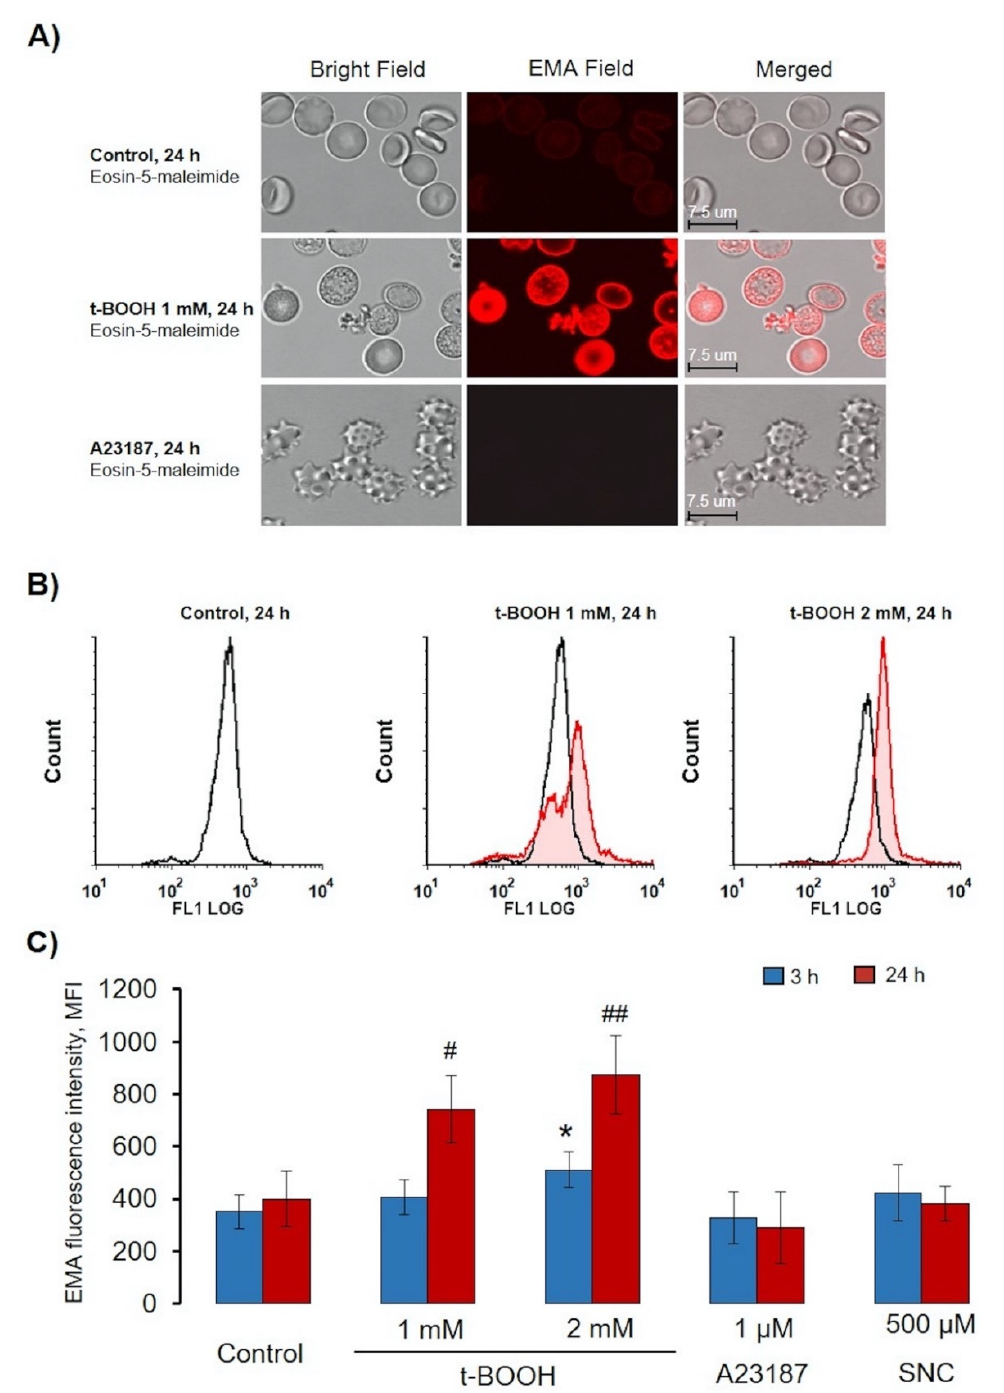
Figure 10. t-BOOH-induced oxidative stress led to band 3 clustering and MV formation. RBCs (0.5 × 10 9 cells / mL) were incubated as indicated with t-BOOH, A23187, and SNC at the indicated times, followed by EMA staining (0.07 mM, 40 min). ( A ) Representative confocal images of t-BOOH transformed RBCs. RBCs were processed for confocal microscopic analysis as described in the Materials and Methods section (Section 2.2.7). ( B ) Original histograms of EMA fluorescence intensity after 24 h t-BOOH treatment. ( C ) Quantification of flow cytometry data. Data are presented as mean ± SD ( n = 7), one-way ANOVA, Levene’s test > 0.05, Tukey HSD post hoc (3 h) was used, * p < 0.05, compared to 3 h control; Levene’s test < 0.05, Tamhane T2 post hoc (24 h) was used, # p < 0.05, ## p < 0.001 compared to 24 h